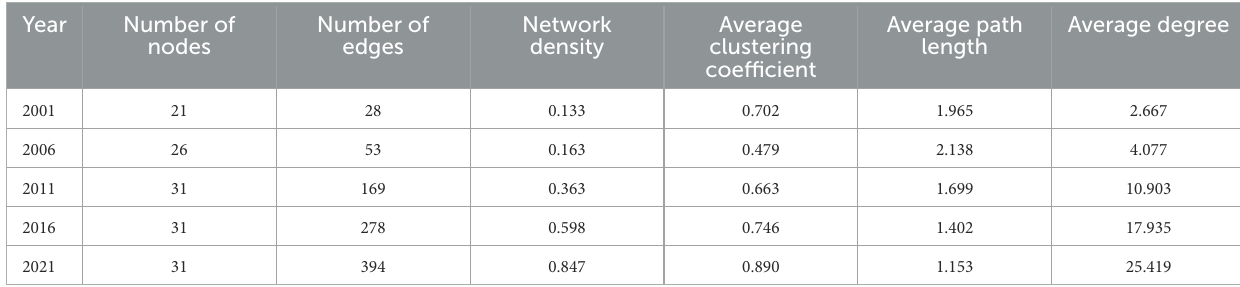
TABLE 3 Overall characteristics of China’s low-carbon patent cooperation